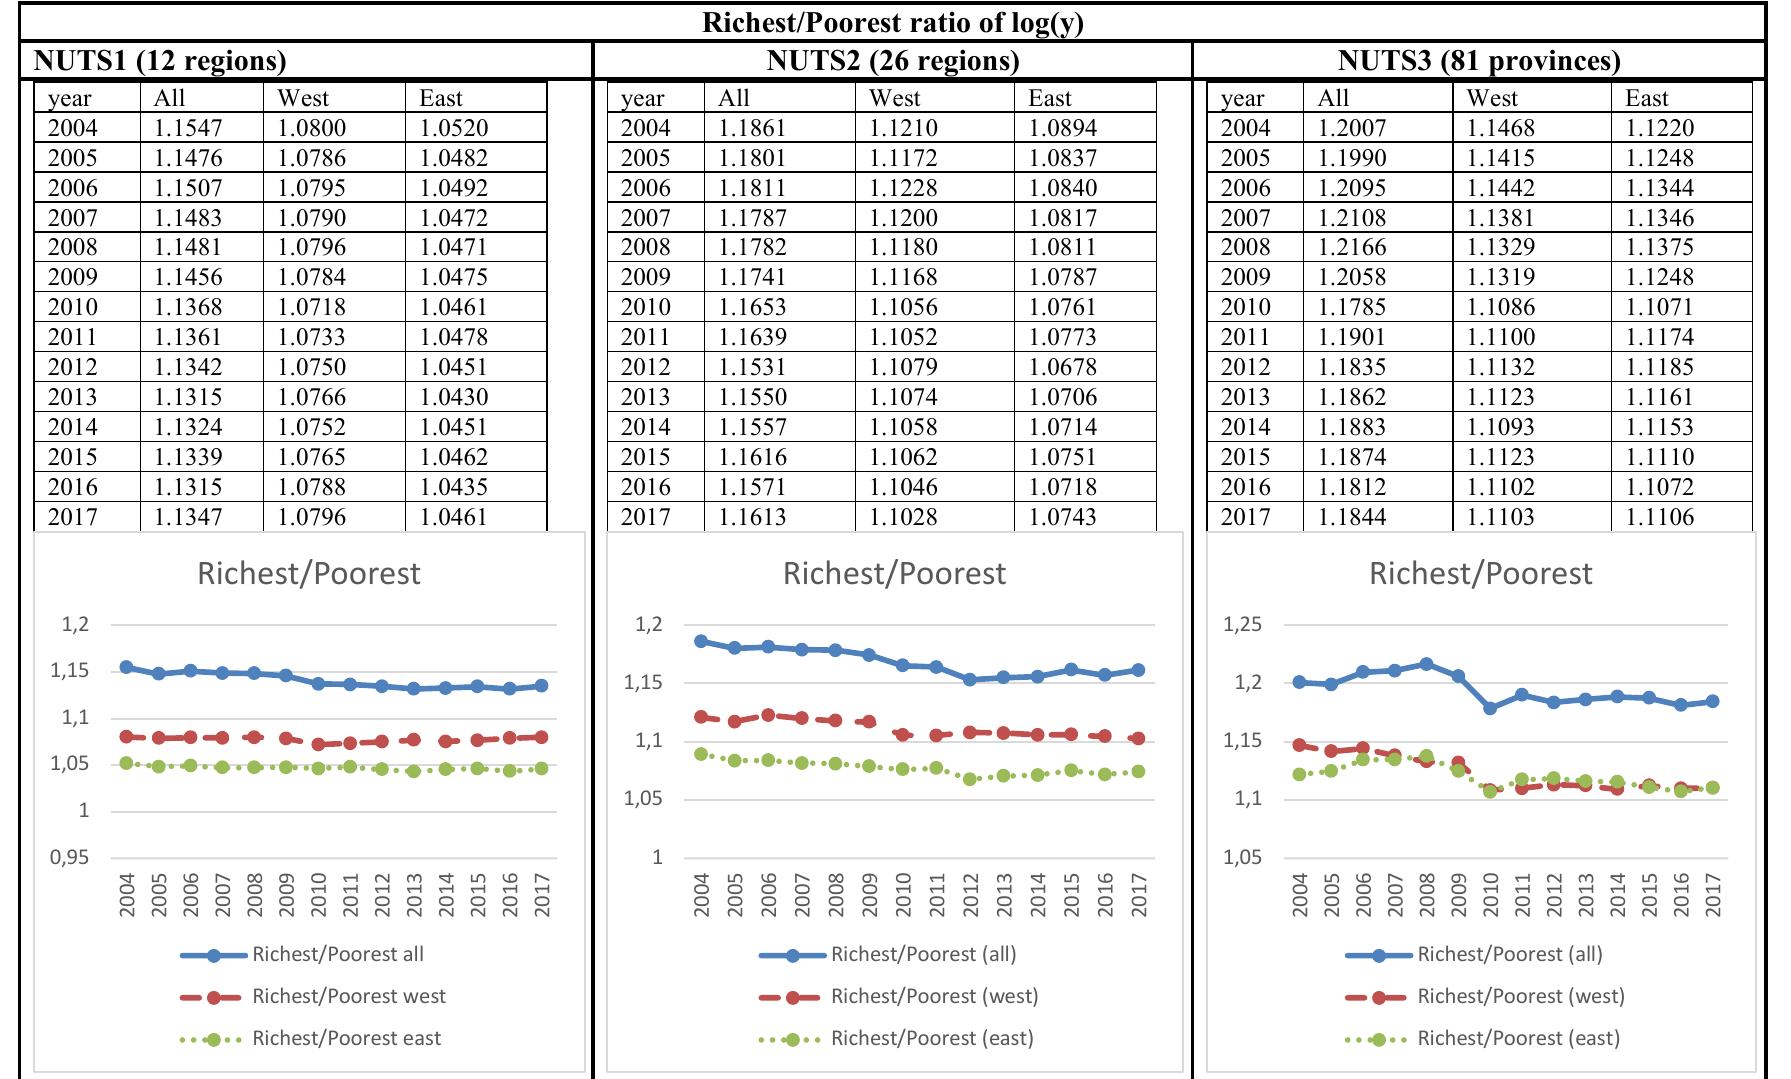
Table 5: Richest Poorest